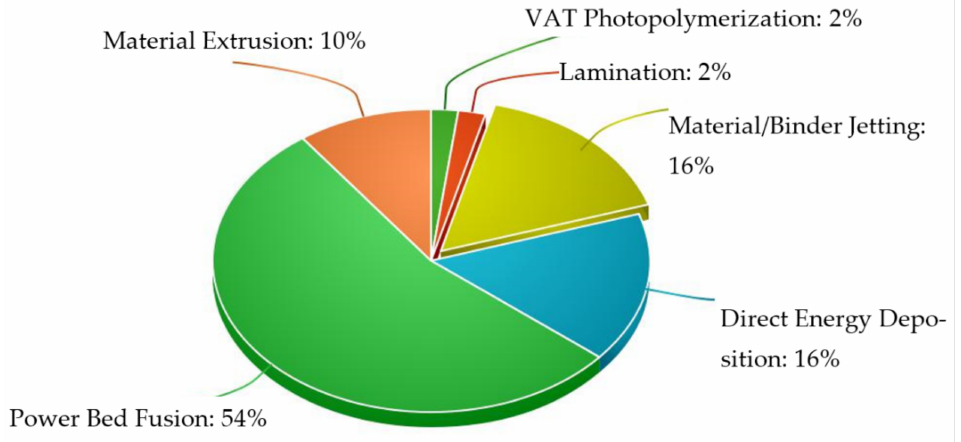
Figure 2. Metal Additive Manufacturing Market in